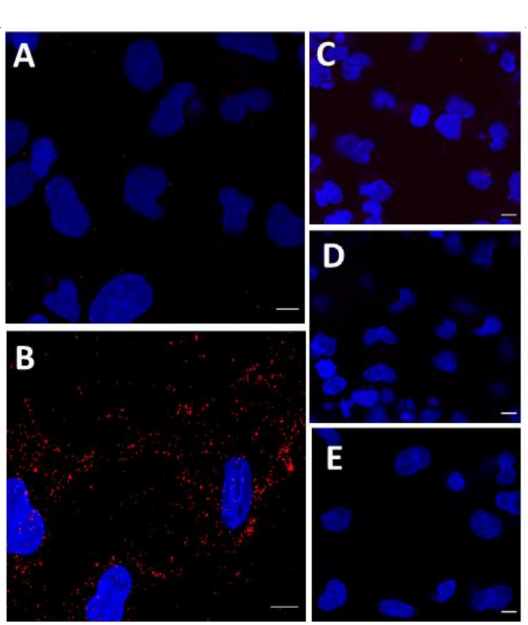
Figure A1. Protein–protein interactions visualized as red fluorescent spots on transfected NS-SV-AC with HA-CT ( A ) or HA-AQP5 ( B ). Negative controls were performed using NS-SV-AC transfected with HA-AQP5 in the absence of anti-HA antibody ( C ), anti-Ezrin ( D ), or both primary antibodies ( E ). Scale bar, 10 µ m.